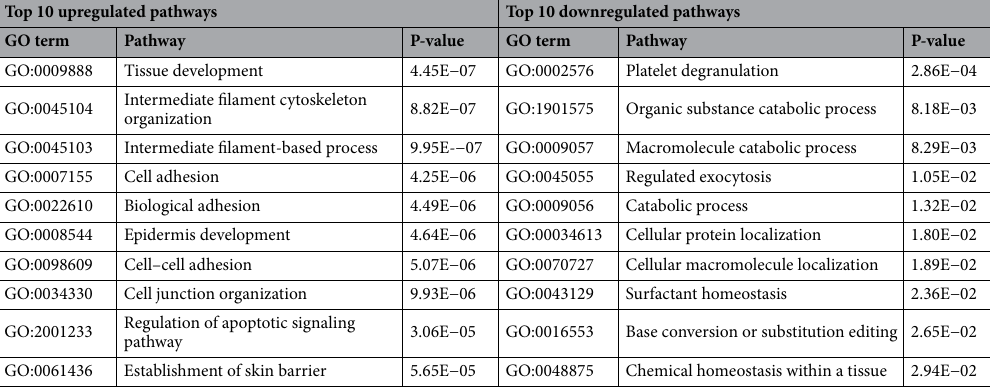
Top 10 upregulated pathways Top 10 downregulated